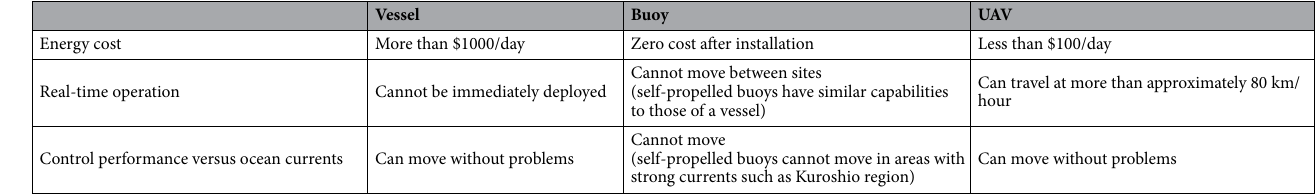
Table 1. Comparison of sea surface platforms capable of GNSS-A observations in terms of energy cost, real- time operation ability, and sea surface control performance versus ocean